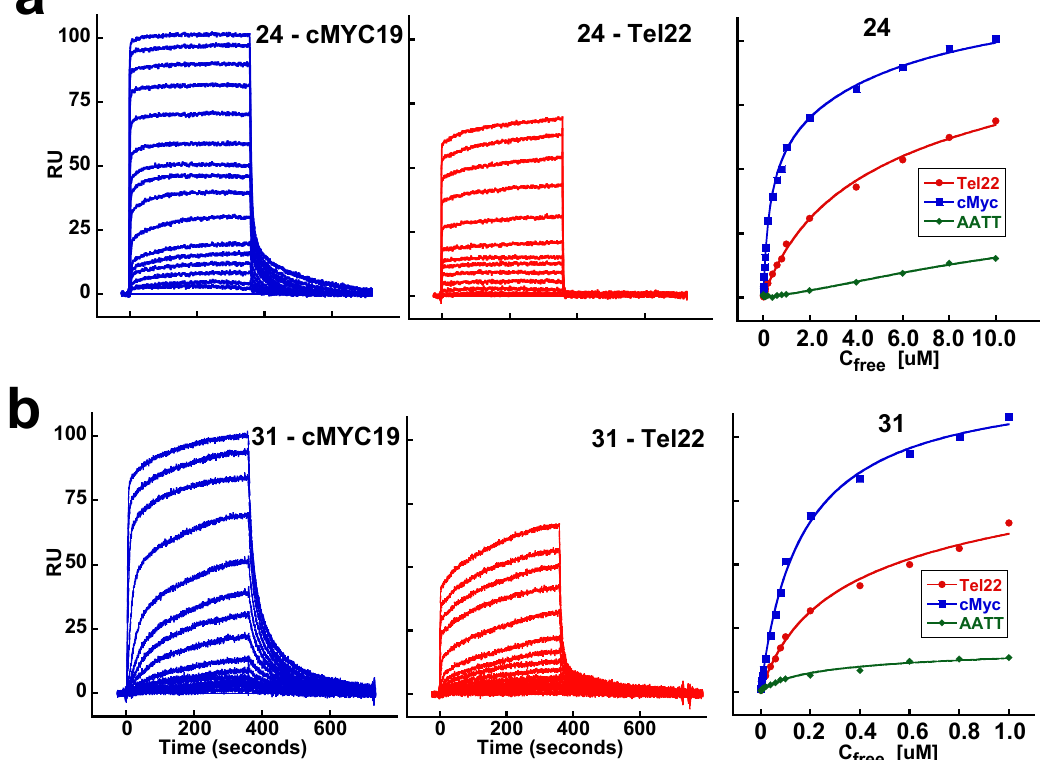
Figure 2. SPR sensorgrams and the steady-state binding plots for the parent cyanine ( 24 , panel a ) and the brominated analog ( 31 , panel b ) with Tel22 and cMYC19 quadruplexes and a control duplex (AATT). The injected concentration range for 24 is 10 nM–10 µM and for 31 is 10 nM–1 µM. The binding plots were obtained by fitting the steady-state response values (RU) as a function of free ligand concentration (C to a two-site binding model. The estimated equilibrium binding affinities ( K reported in Table 2.